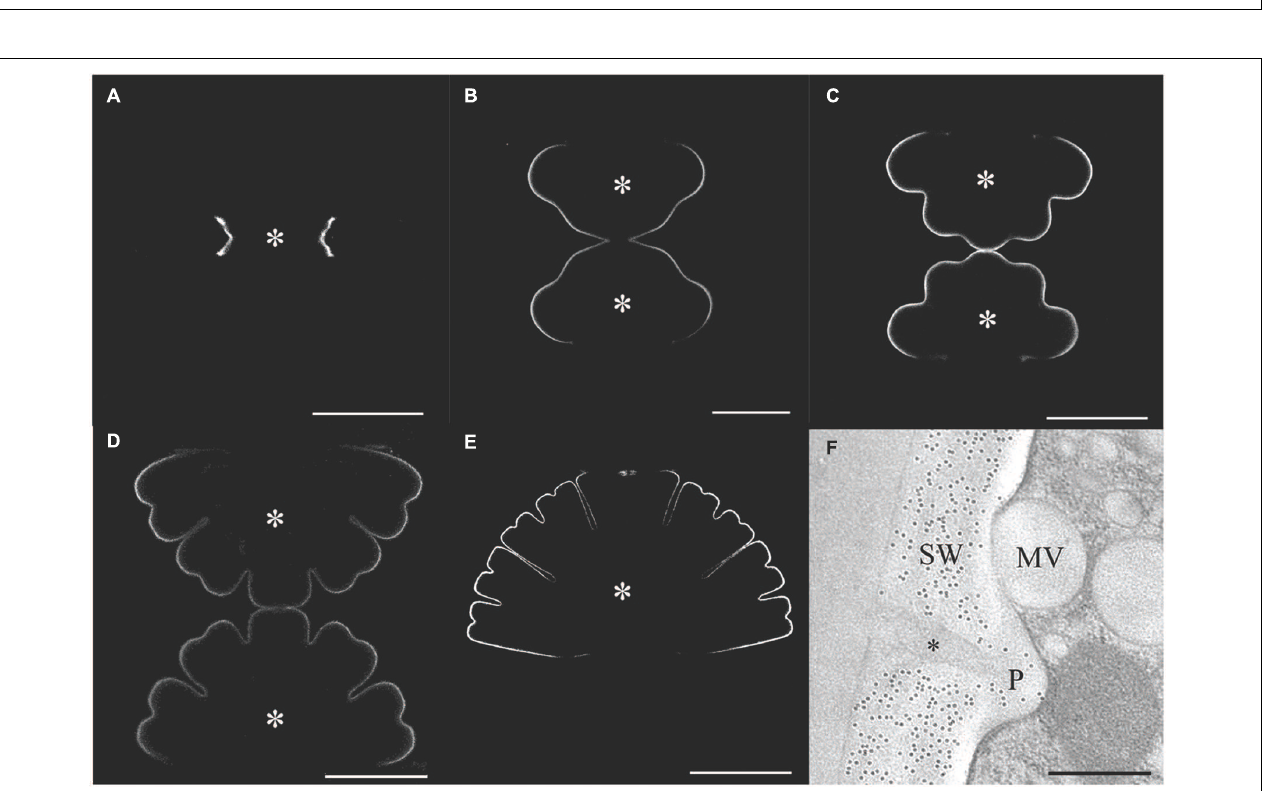
FIGURE 4 | Immuno labeling of the cell wall of developing stages of Micrasterias . (A–E) Primary wall of different developing stages of Micrasterias labeled by polyclonal anti-xyloglucan antibody. Asterisks indicate growing semicells (scale bars are 50 µ m). (F) Immunogold labeling of the non-growing secondary wall by BG1 antibody recognizing (1-3, 1-4)-ß- D -glucans. Mucilage (asterisk) in cell wall pore (P) and mucilage vesicle are not labeled (scale bar is 0.5 µ m). Reprinted with permission from Eder et al. (2008), Copyright © 2008 Phycological Society of America.